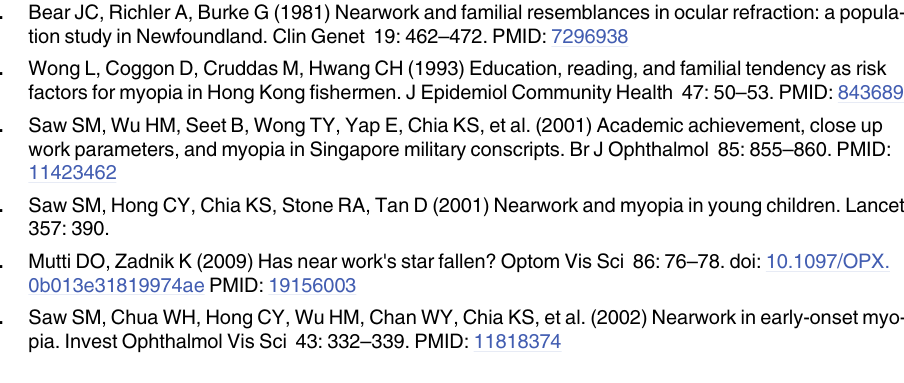
S1 Table. Associations of Nearwork Activities with SER in